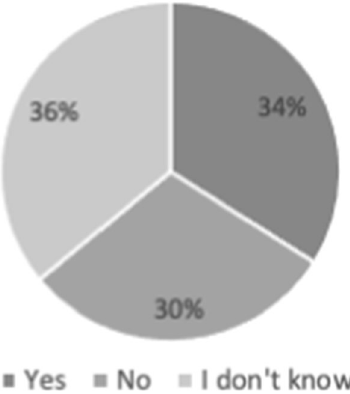
Fig. 4 Distribution of answers to the question whether